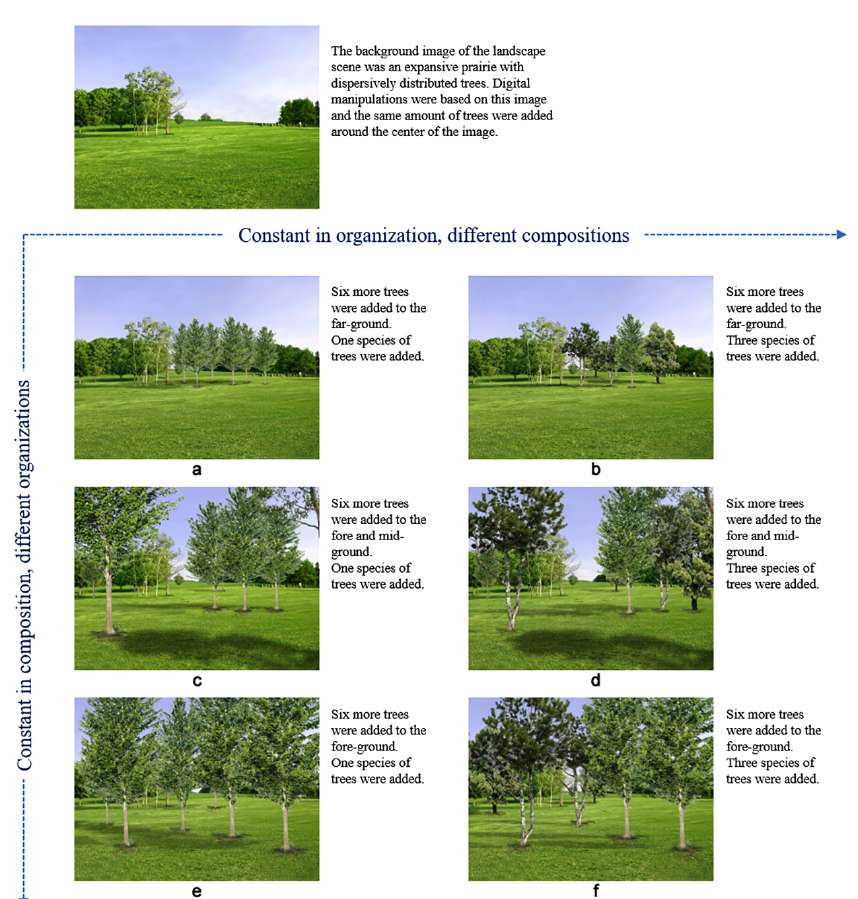
Figure 2. The landscape scenes used in the